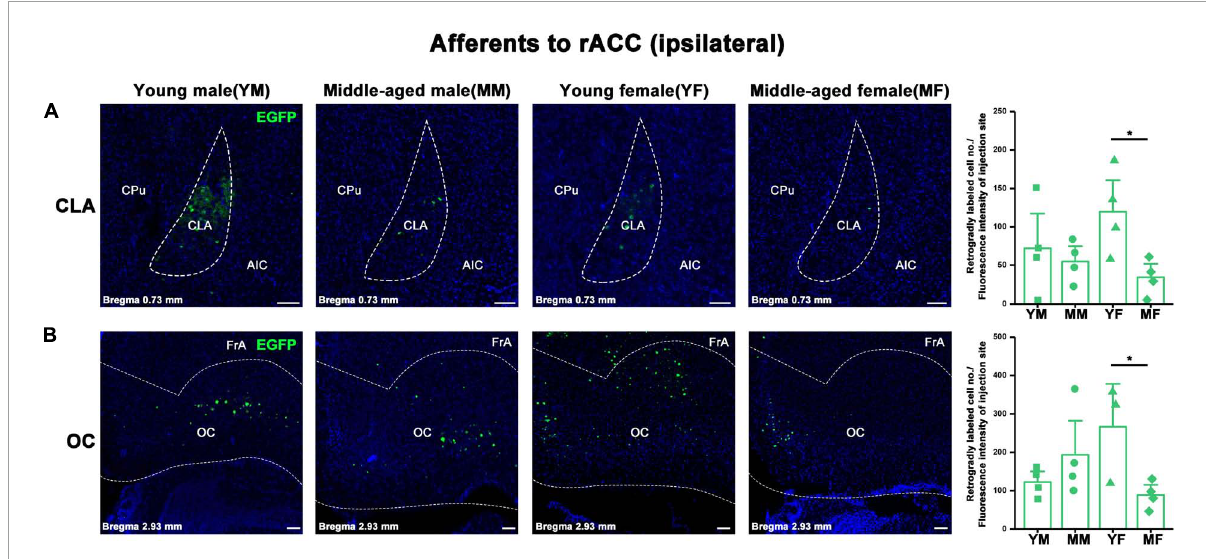
FIGURE5 Ipsilateral brain regions with retrograde projections of the rACC in mice of different ages and sexes (A,B) Left: Representative images of retrogradely labeled neurons in the CLA; OC regions of young male, middle-aged male, young female, and middle-aged female mice. Right: Retrogradely labeled cell number divided by fluorescence intensity of injection site ( n = 4 young males, n = 4 middle-aged males, n = 4 young females in the CLA, n = 3 young females in the OC, n = 4 middle-aged females). * p < 0.05. Scale bar = 100 µ m. Error bars represent